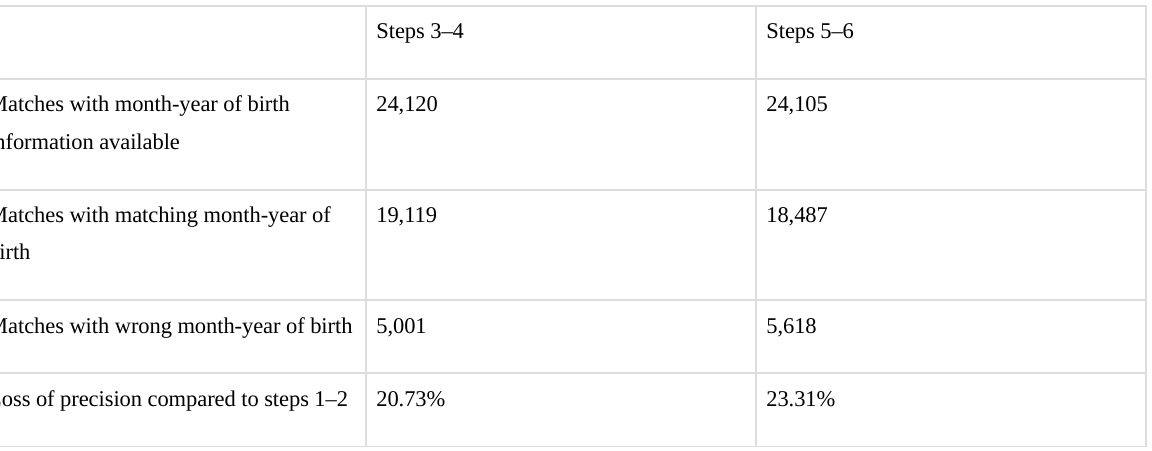
Table A1. Loss of precision when DOB requirements removed from matching